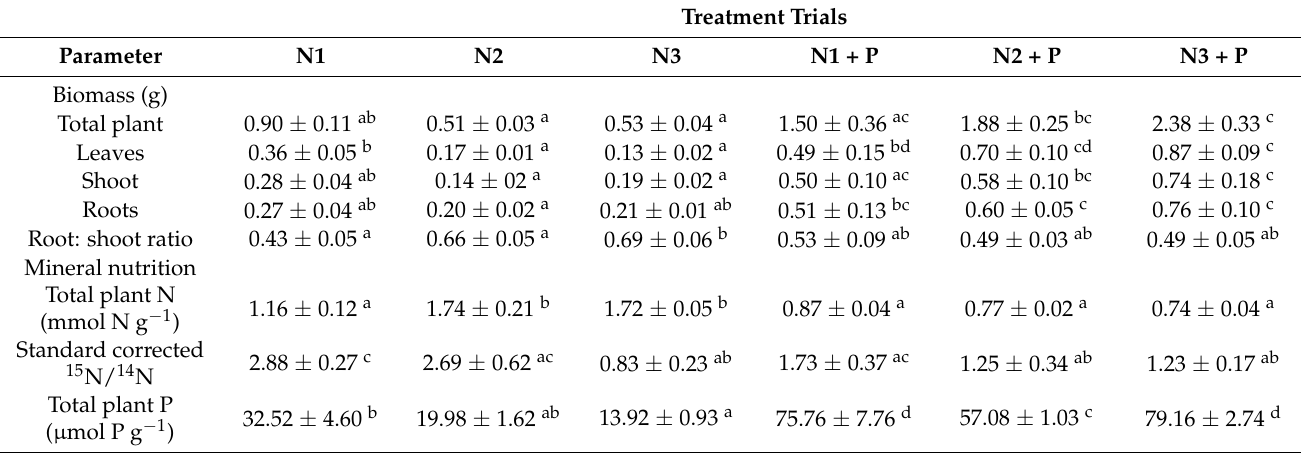
Table 1. Biomass and mineral nutrition of 180-day-old V. nilotica saplings grown in Ukulinga Farm soils receiving N and P fertilizer treatments Values represent mean ± SE, based on n = 5. Significant differences ( p < 0.05) among treatments are denoted by different superscript